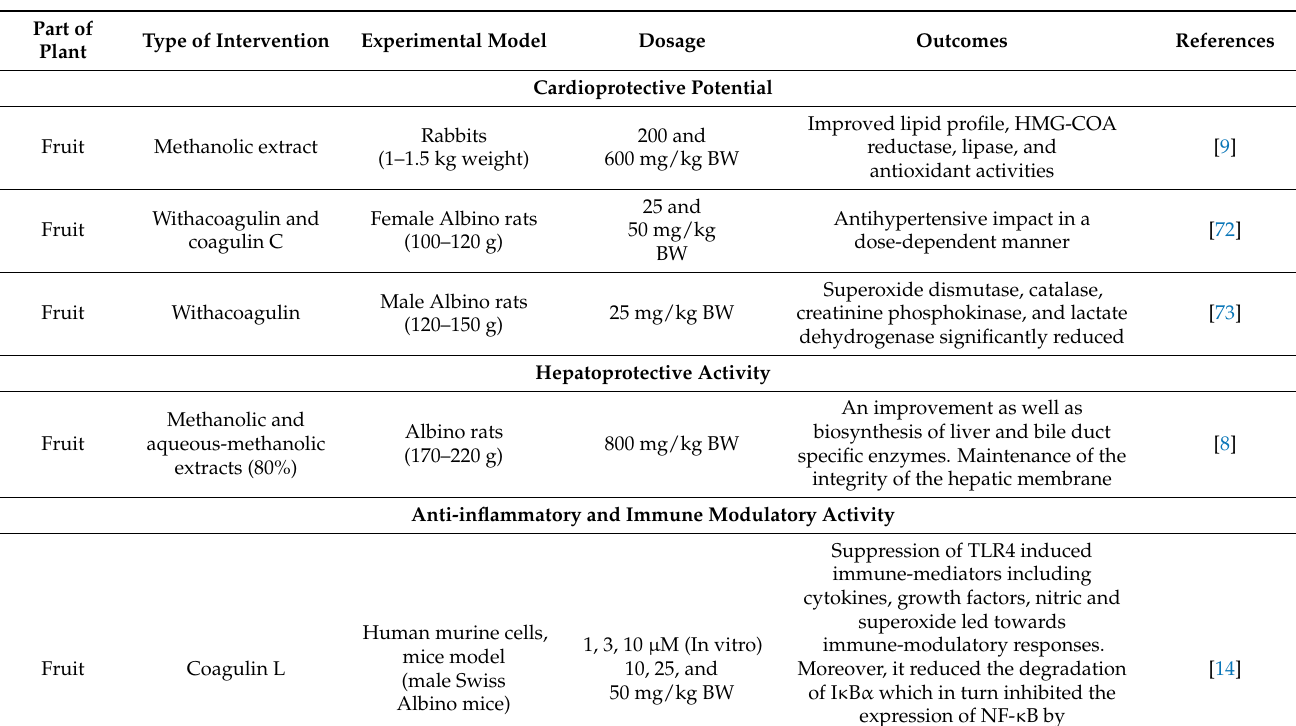
Table 3. Therapeutic potential of W.